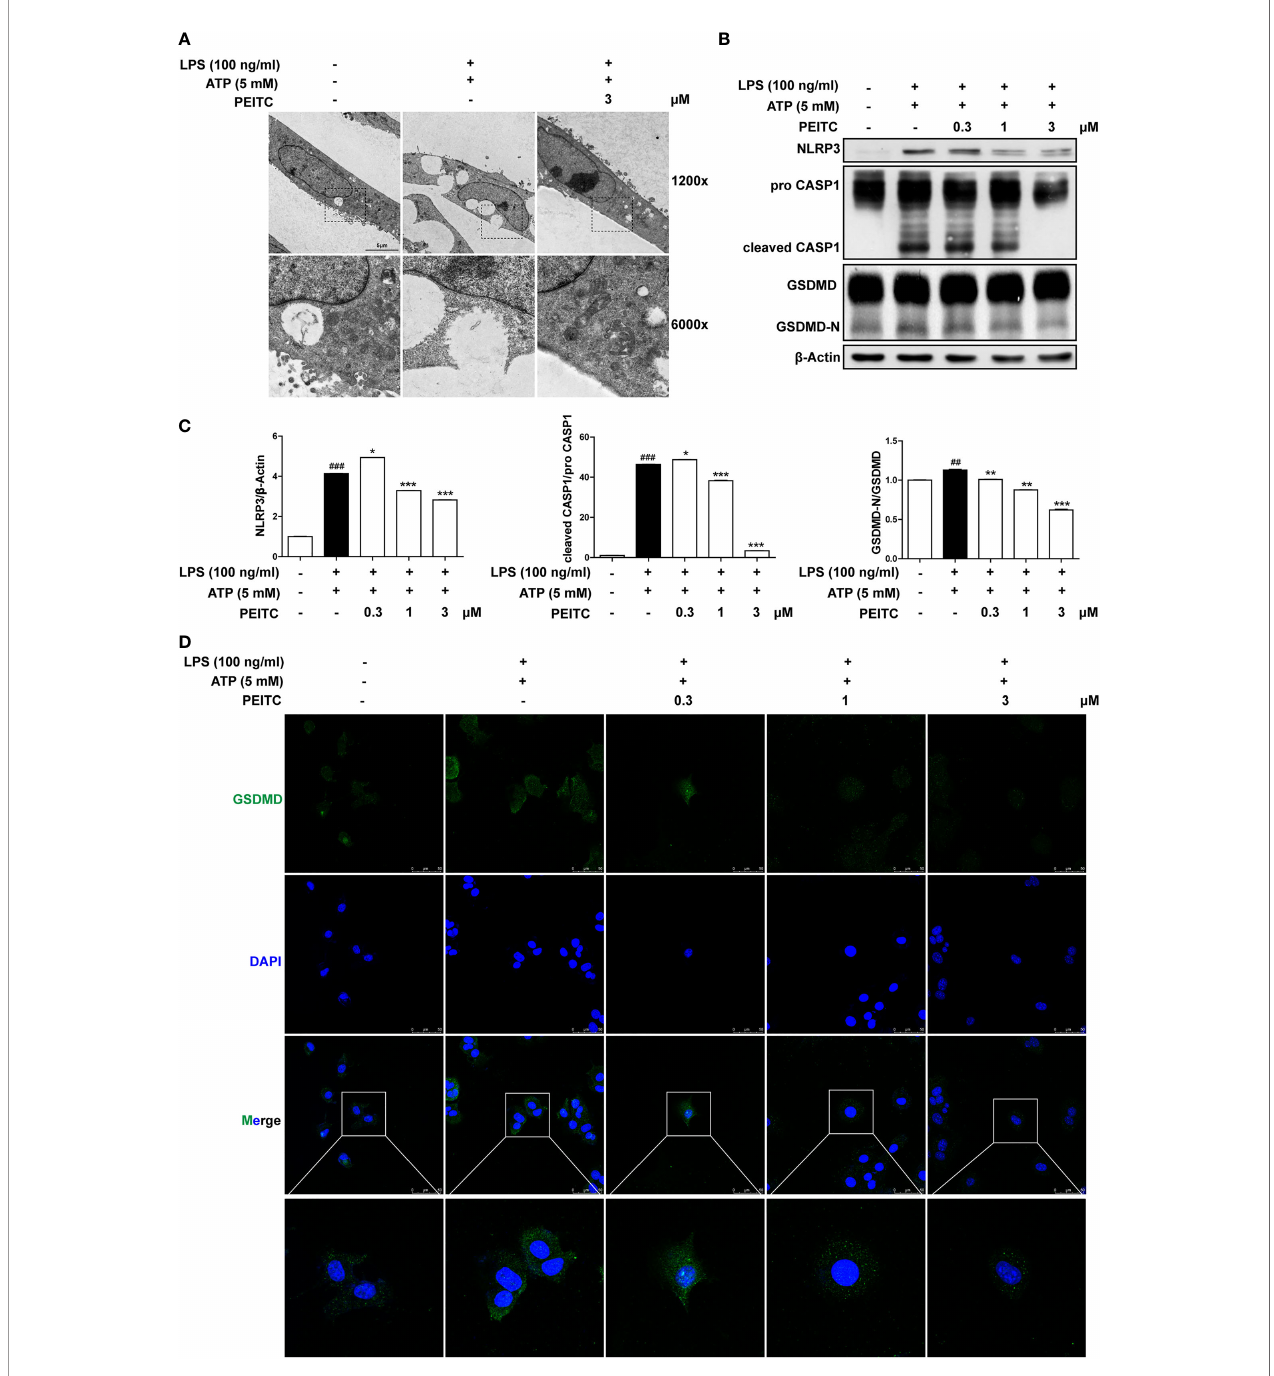
FIGURE 6 | PEITC inhibited pyroptosis in AML12 cells treated with LPS and ATP in vitro . (A) Representative electron micrographs of cell morphology from each group. Scale bar, 5 µm. (B, C) Immunoblot and statistical analysis of NLRP3, pro-CASP1, cleaved CASP1, GSDMD, GSDMD-N, and b -actin. (D) Immuno fl uorescence staining of GSDMD. Scale bar, 50 µm. Data are presented as means ± SEM. ## p < 0.01, ### p < 0.001 vs. blank, * p < 0.05, ** p < 0.01 *** p < 0.001 vs. LPS+ATP